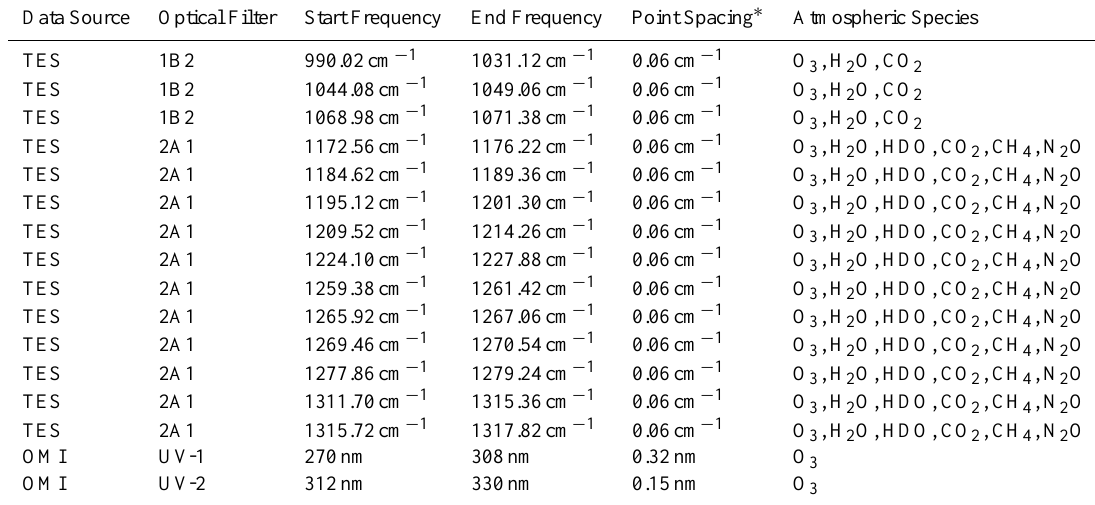
Table 1. Spectral Regions used in Joint TES and OMI Ozone